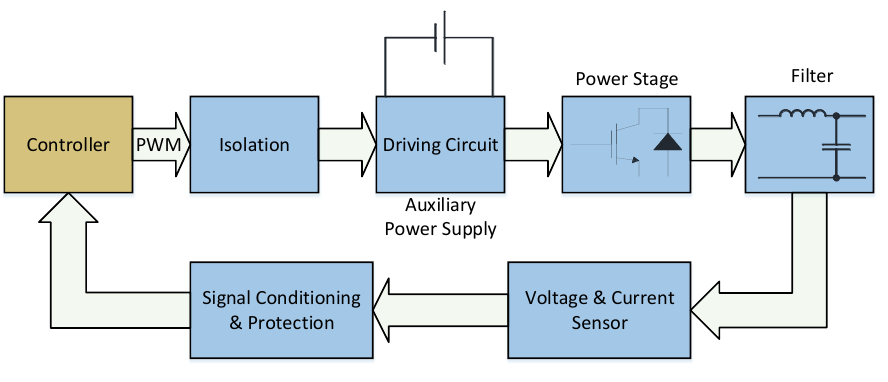
Figure 9. Primary controller in SPSS.